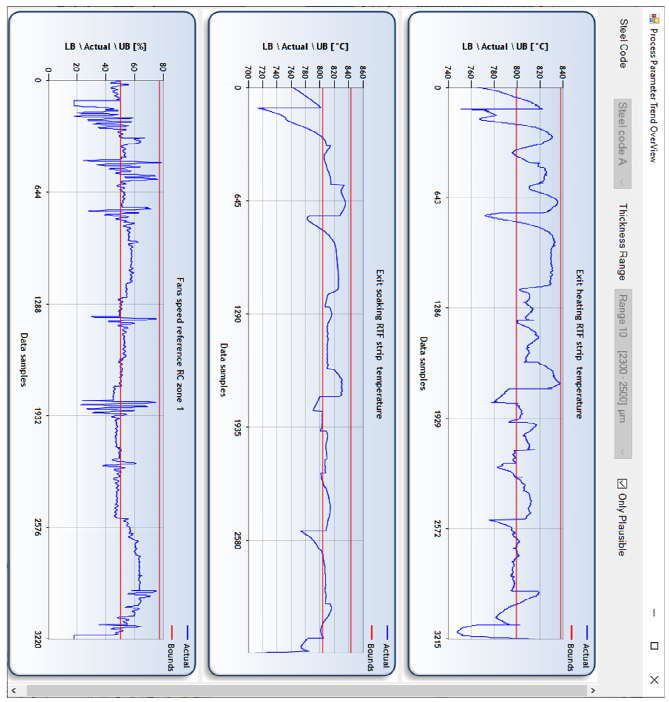
Figure 11. Process parameters trend overview.